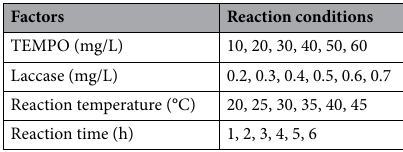
Table 1. Oxidizing conditions of the TEMPO